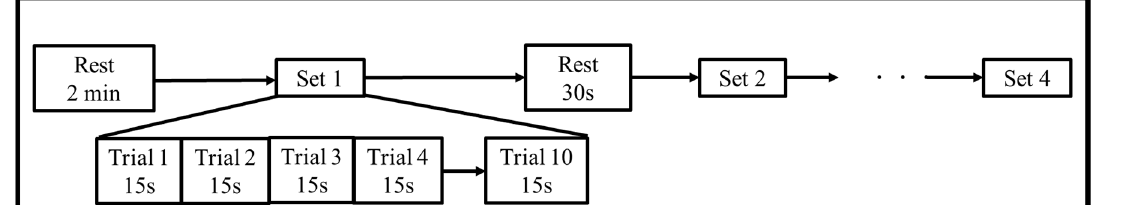
Figure 2. Experimental task flow .